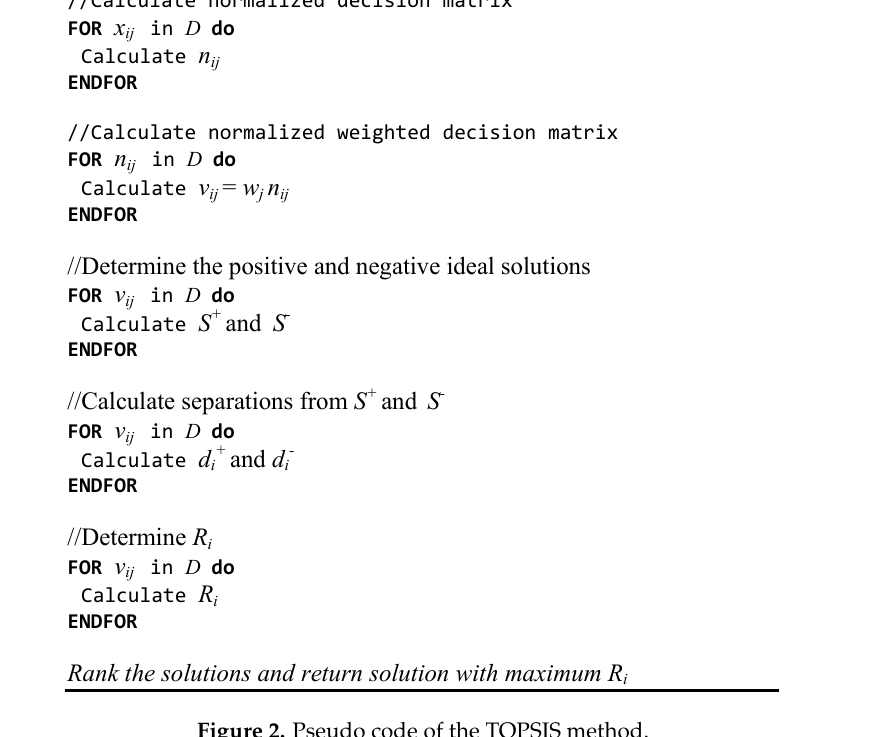
Figure 2. Pseudo code of the TOPSIS method. Table 2. Specifications of turbines used in the